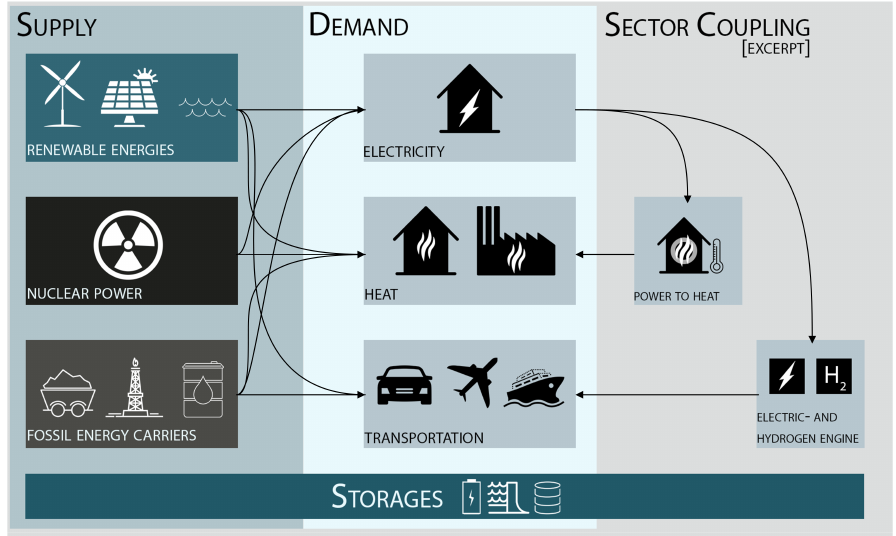
Figure 5. Stylized graph of the stucture of the Global Energy System Model